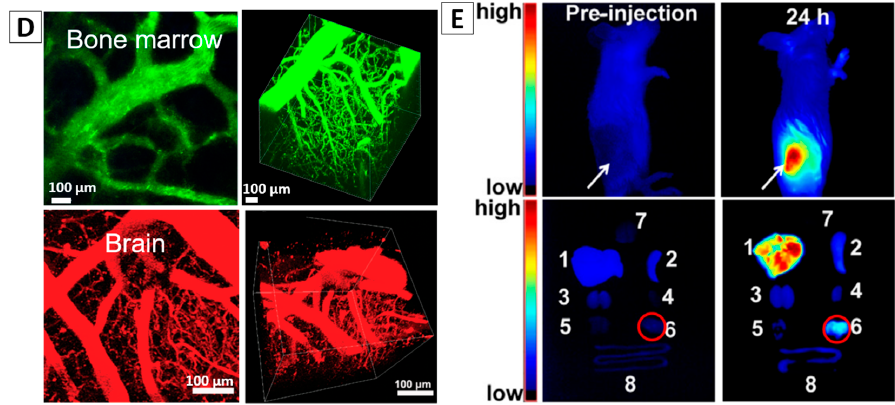
Figure 5. ( A ) Non-targeting cell imaging via organic An18-F127 NPs [52] (left panel) and targeting cancer cell imaging of folate-functionalized AIE-SiO 2 NPs (right panel) [51]; ( B ) targeted imaging of microtubules in HeLa cells labelled with the Red-AIE-OXE NPs [12]; ( C ) CLSM and STED imaging of the microtubule structures with Red-AIE-OXE NPs and the corresponding line profile of the position indicated by the arrow heads (i) and (ii) [12]; ( D ) In vivo two-photon imaging of bone marrow blood vessels [63] (up) and 3TPFI imaging of brain blood vessels (down) of mice treated with AIE NPs [64]; ( E ) AIEgen-based NPs for non-invasive fluorescence imaging of tumor-bearing mice and the dissected tumors and organs (The white arrows indicate tumor sites and the red circles indicate dissected tumors. 1—Liver, 2—Spleen, 3—Kidney, 4—Heart, 5—Lung, 6—Tumor, 7—Brain, 8—Intestine) [65]. Reprinted with permission from ref. [12,51,52,63,64,65], respectively. Copyright 2017 Wiley-VCH,